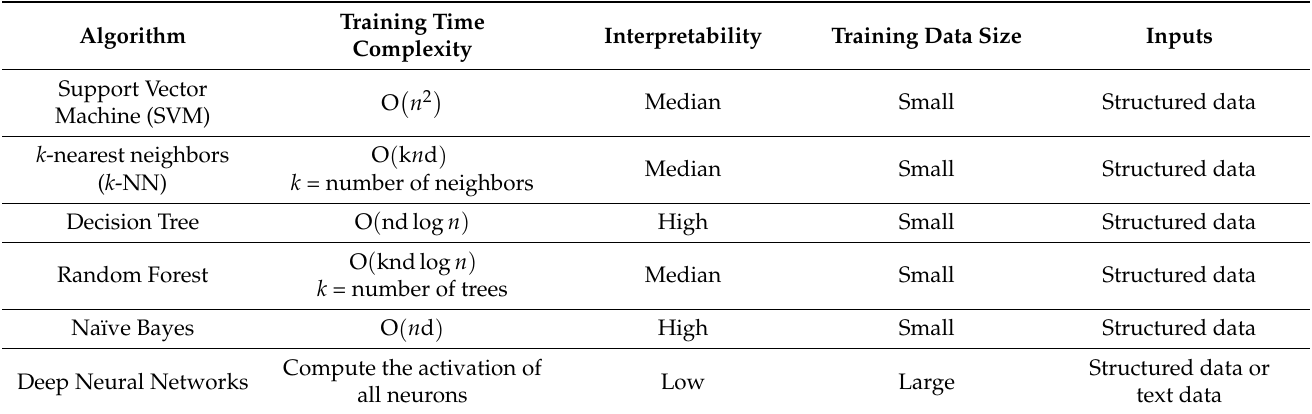
Table 2. Machine learning algorithms for detecting phishing websites. Here, n is the number of training instances, and d is the number of dimensions of the